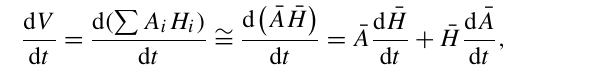
Figure 7. Scatterplot of IceAgeDerived and CryoSat-2 monthly mean ice thickness, where the CryoSat-2 data are from (a) AWI, (b) NASA GSFC, and (c) CPOM. The dashed line represents the regression line of IceAgeDerived monthly mean ice thickness on the CryoSat-2 data, with slope, intercept, and R 2 indicated.